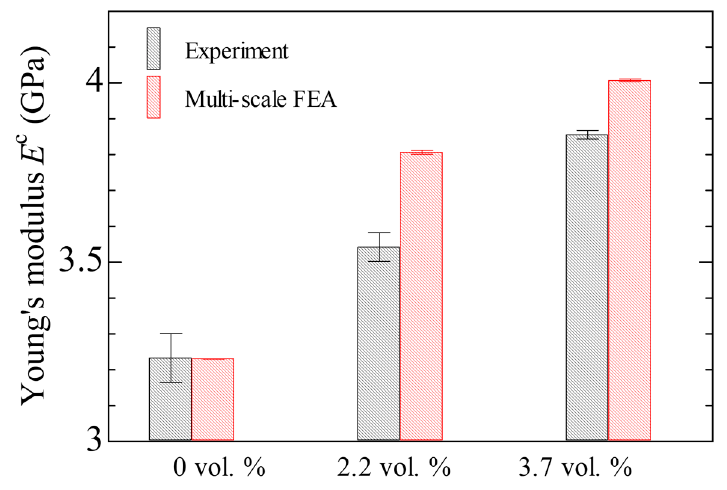
Figure 8. Predicted and experimental Young’s modulus for neat epoxy and CNF/epoxy composites.